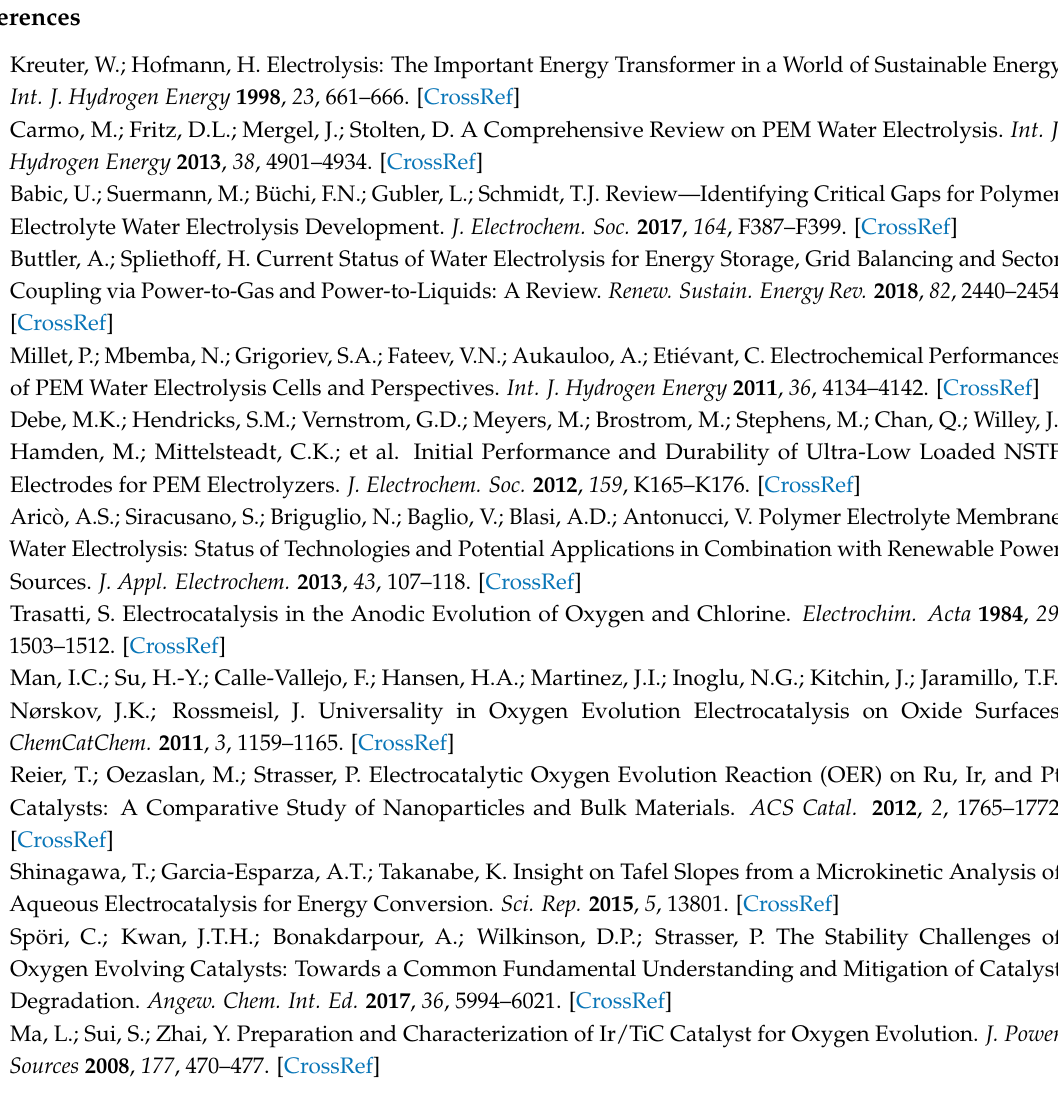
Figure S1. TEM images and particle size distribution histograms for IrO x /M-SnO 2 (M = Nb, Ta, and Sb) catalysts; Figure S2. SEM and TEM images and particle size distribution histograms for a conventional catalyst; Figure S3. XP spectra of IrO x /M-SnO 2 (M = Nb, Ta, and Sb) catalysts; Figure S4. I-E curves of single cells, in which the current is shown as the apparent MA per mass of iridium metal; Figure S5. SIM image of the cross-section at the anode for the CCM with IrO x /Sb-SnO 2 catalyst; Appendix S1. Calculation method for the amount of the M-SnO 2 supports; Appendix S2. Calculation method for specific surface areas of IrO 2 ; Table S1. Diameters of IrO 2 ( d IrO2 ) and specific surface areas of IrO 2 (S IrO2